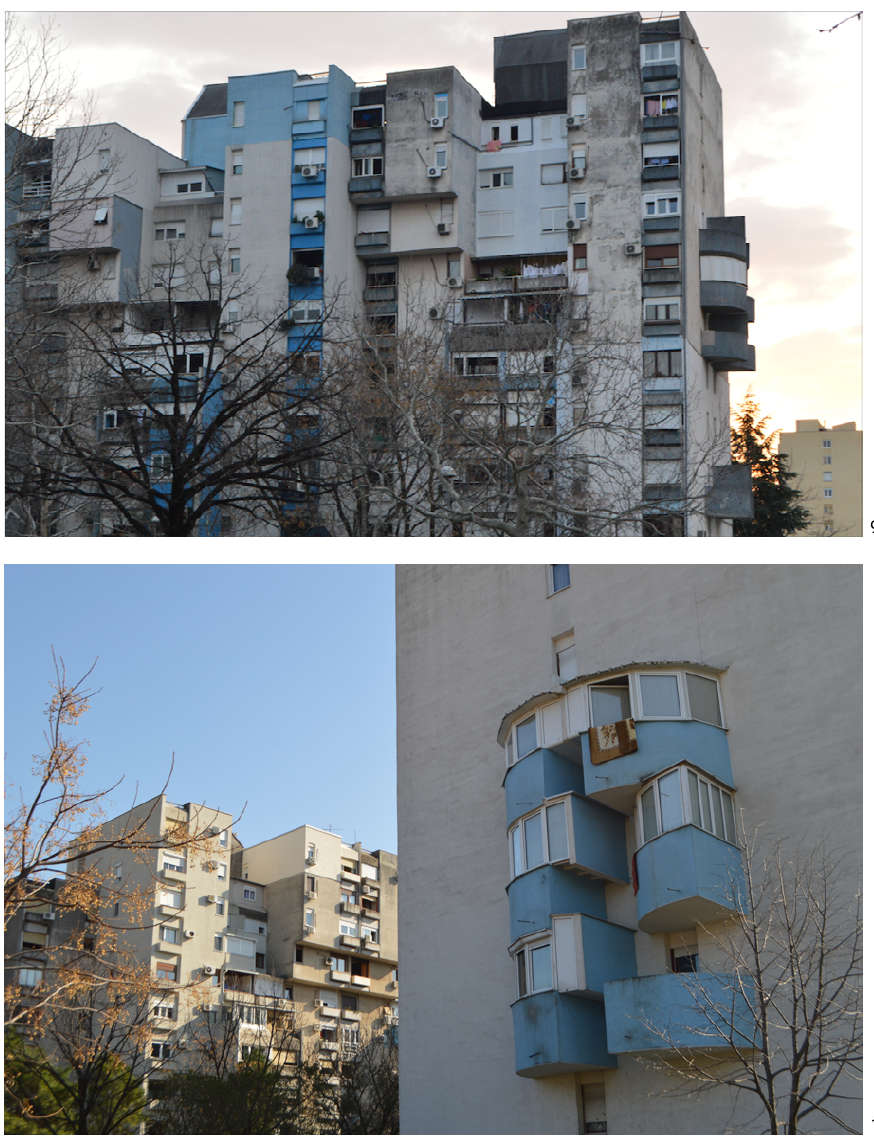
Horvat)Fig. D3, north facade, February 2019. (Photo: Lea D3, west facade, February 2019. (Photo: Lea